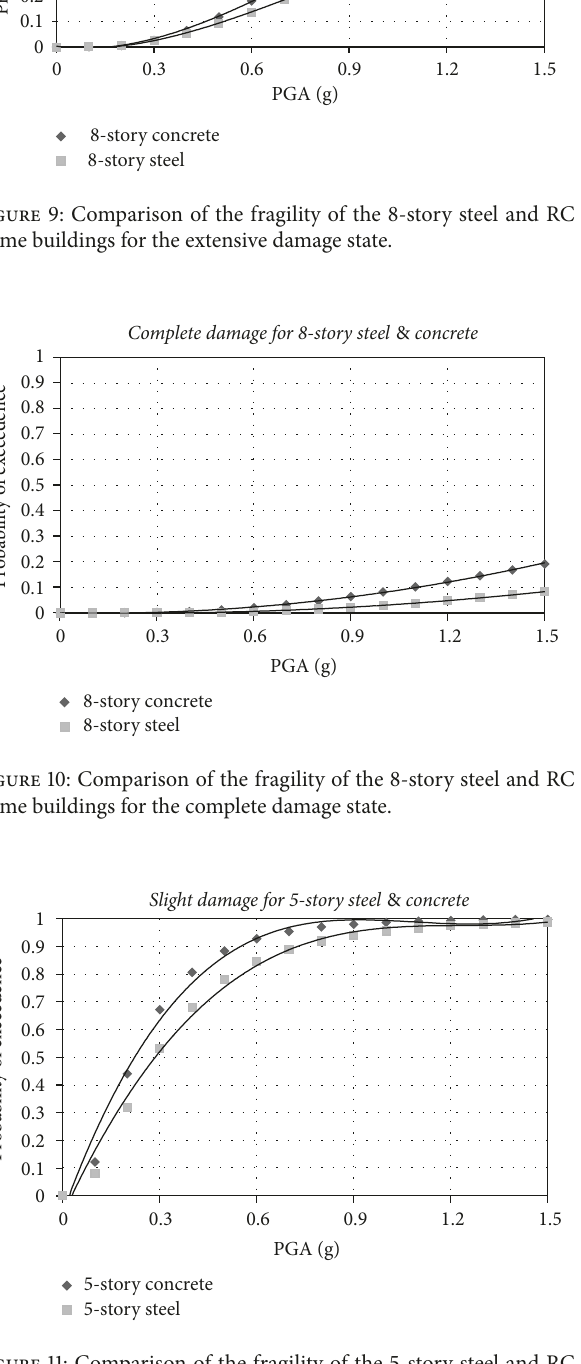
Figure 11: Comparison of the fragility of the 5-story steel and RC frame buildings for the slight damage state.